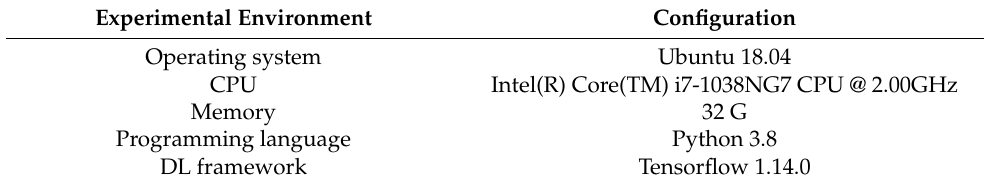
Table 1. Experimental environment